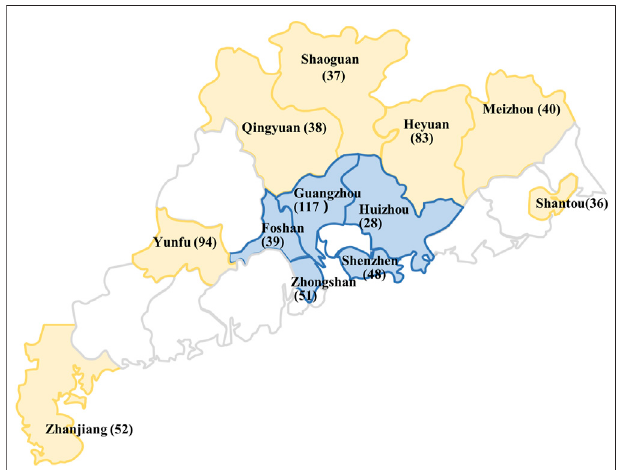
FIGURE 1 | Regional division and the distribution of the mutated SLC10A1 alleles in different cities of Guangdong province, including the cities within the Pearl River Delta (blue) and the peripheral region (yellow). The numbers of the mutated SLC10A1 alleles from different cities were presentedinparentheses.This fi gurewasgeneratedbymeansofthesoftware Microsoft PowerPoint 2019. The base map was created by incrementally assembling the outlines of the Chinese administrative regions, which could be downloaded via the URL link